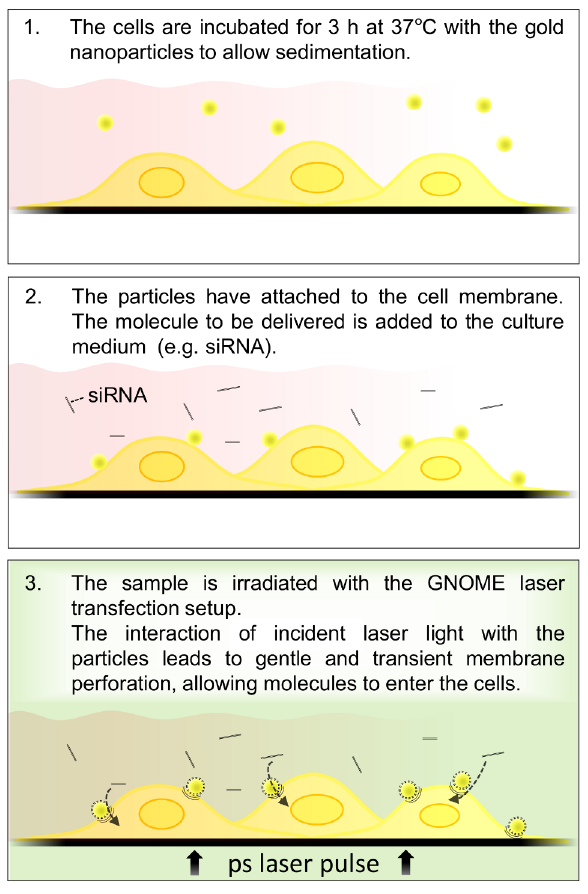
Figure 2. Experimental procedure for GNOME laser transfec- tion. Cells are incubated with AuNP (1), the molecule to be delivered is added (2) and the sample is irradiated to permeabelize the cell membrane (3). Drawings are not true to scale.